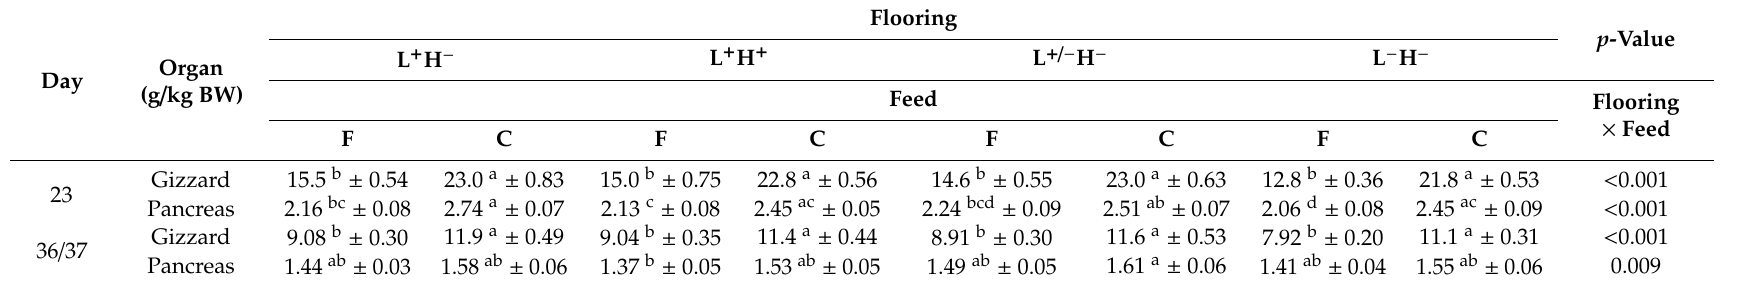
Table 4. Relative mass of the gizzard and pancreas (g / kg BW ± SEM) of broilers at dissection days (flooring × feed).